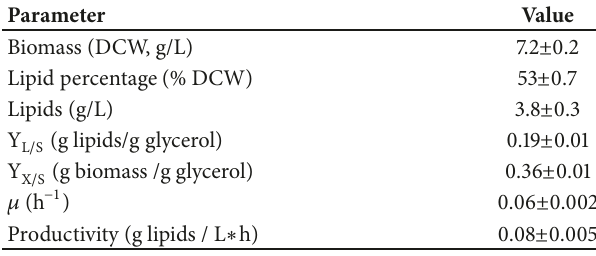
Table 1: Maximum biomass, lipid percentage, and lipids in flasks